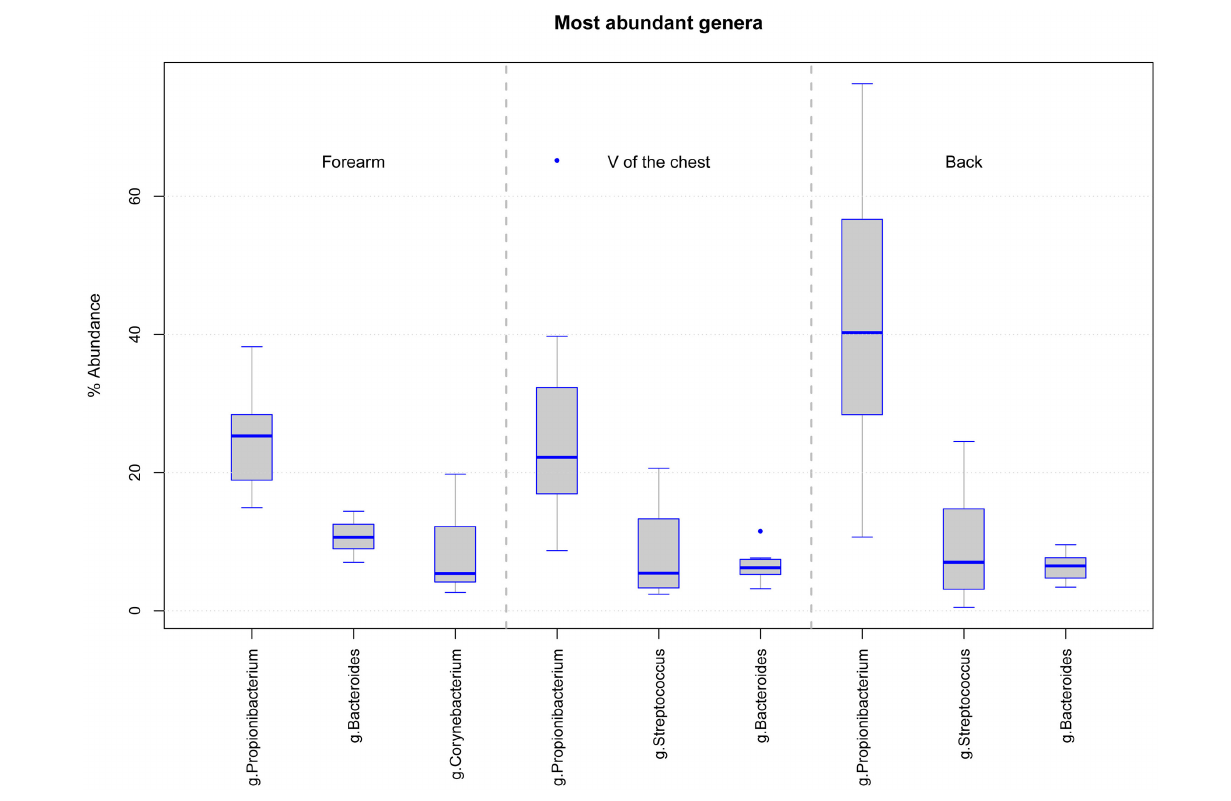
FIGURE 1 | Boxplot diagram of the relative abundance for the three dominating genera in samples from each body location at d0 (DNA isolation after over-night freezing): forearm samples are dominated by Propionibacterium , Bacteroides , and Corynebacterium and V of the chest and back samples by Propionibacterium , Streptococcus , and Bacteroides